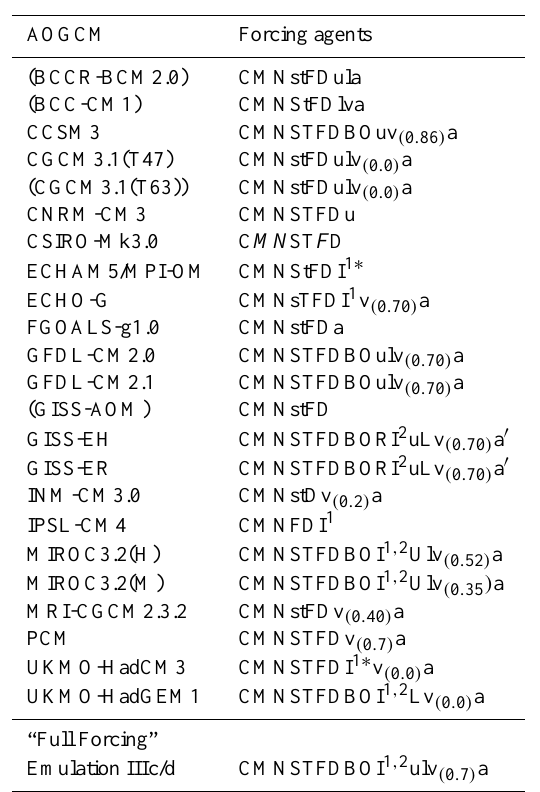
Table 2. The subsets of forcing agents considered during the calibration III exercise to match the setup of CMIP3 AOGCM multi-forcing runs (cf. Table 10.1, Meehl et al., 2007). The forc- ing agents included for the multi-forcing simulations are indi- cated by the following symbols: C=carbon dioxide; M=methane; N=nitrous oxide; S=stratospheric ozone; T=tropospheric ozone; F=halogenated carbons (CFCs); D=direct SO x aerosol; B=direct black carbon; O=direct organic carbon; R=nitrate aerosols; I 1 =first indirect aerosol effect; I 2 =second indirect aerosol effect; U=mineral dust; L=land use; V=volcanic; A=solar; Capital let- ters denote that a time-variable forcing agent is included for sim- ulations prior to and after 2000; small letters denote that forcing agent varies with time in 20th century (20c3m) simulations and is set constant thereafter; italic letters denote that forcing was included as CO 2 equivalent, hence efficacies were set to 1 during calibration. Bracketed subscripts indicate the applied volcanic forcing scaling factor derived from Fig. 4 in F&T. Note that for some models, the forcing analysis by F&T detects no volcanic forcing ( v ( 0 . 0 ) ), al- though Table 10.1 in Meehl et al. (2007) indicate the inclusion of volcanic aerosols. Future solar forcing in GISS-EH and GISS-ER was assumed to be cyclic in the original simulations, but is here as- sumed constant, denoted by a 0 . Mineral dust (U) forcings and land use albedo (L) effects have been assumed constant after 2000 in all emulations. For ECHAM5/MPI-OM and UKMO-HadCM3, de- noted with a “*”, the first indirect effect was assumed in the MAG- ICC emulations to be equal to the default joint forcing of 1st and 2 nd indirect effect given the substantial negative shortwave forcing analyzed by F&T for these